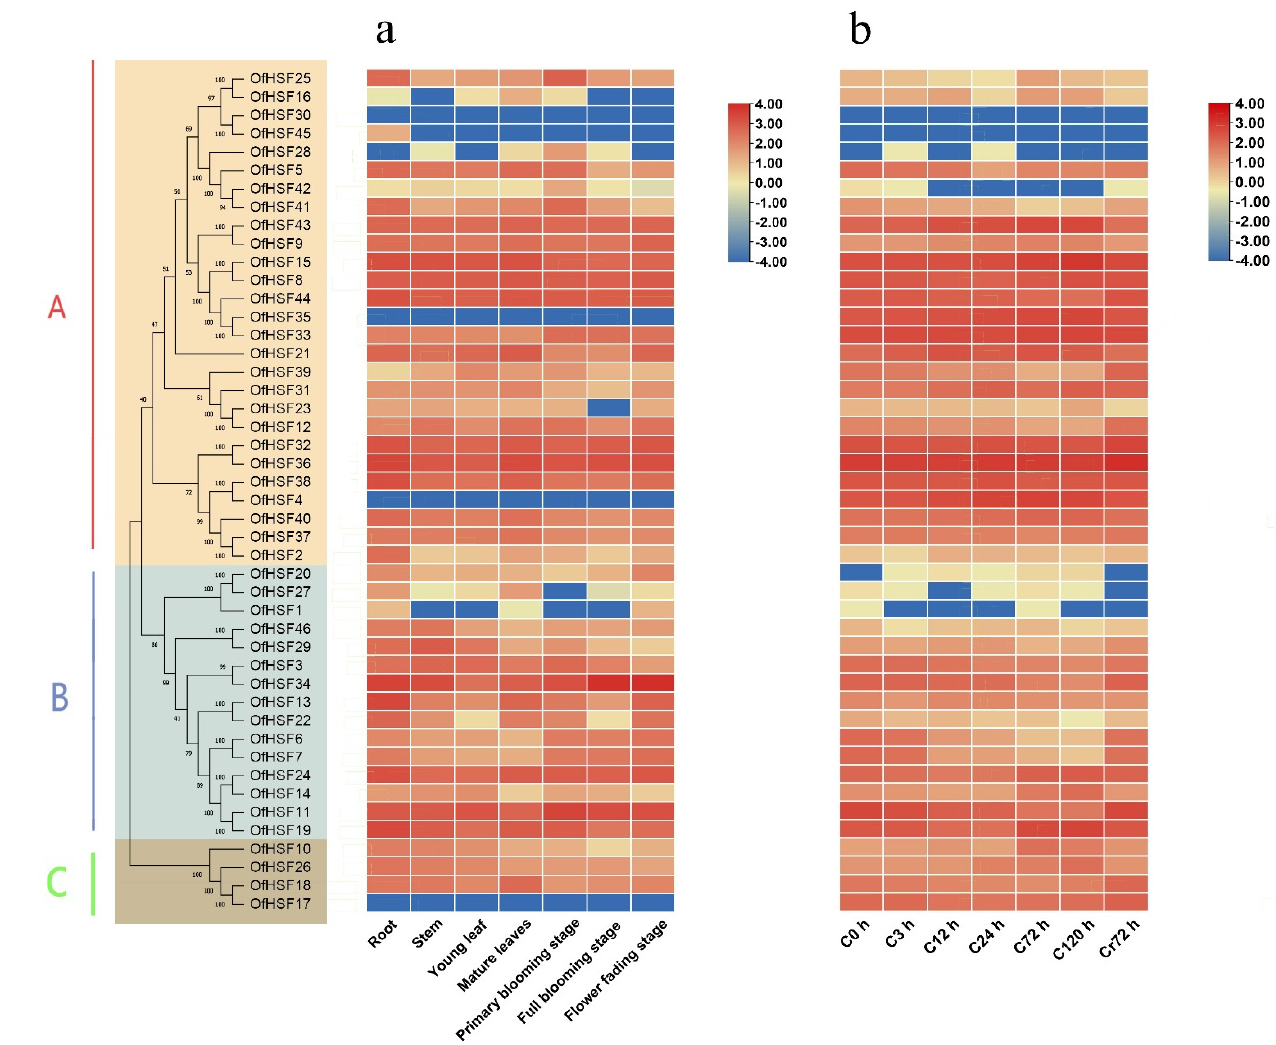
Figure 5. Clustering expression analysis of 46 OfHSF s in seven tissues ( a ) and in response to cold stress ( b ). C0 h, C3 h, C12 h, C24 h, C72 h and C120 h denote the different cold treatment times. The Cr72 h denotes recovery for 72 h after a 5-d cold treatment. The raw counts of OfHSF s were transformed to log 10 (value + 0.0001). The colored histogram on the right of each heat map indicates the corresponding expression levels. The OfHSF s were divided into A, B and C subfamilies and represented by with different colors.